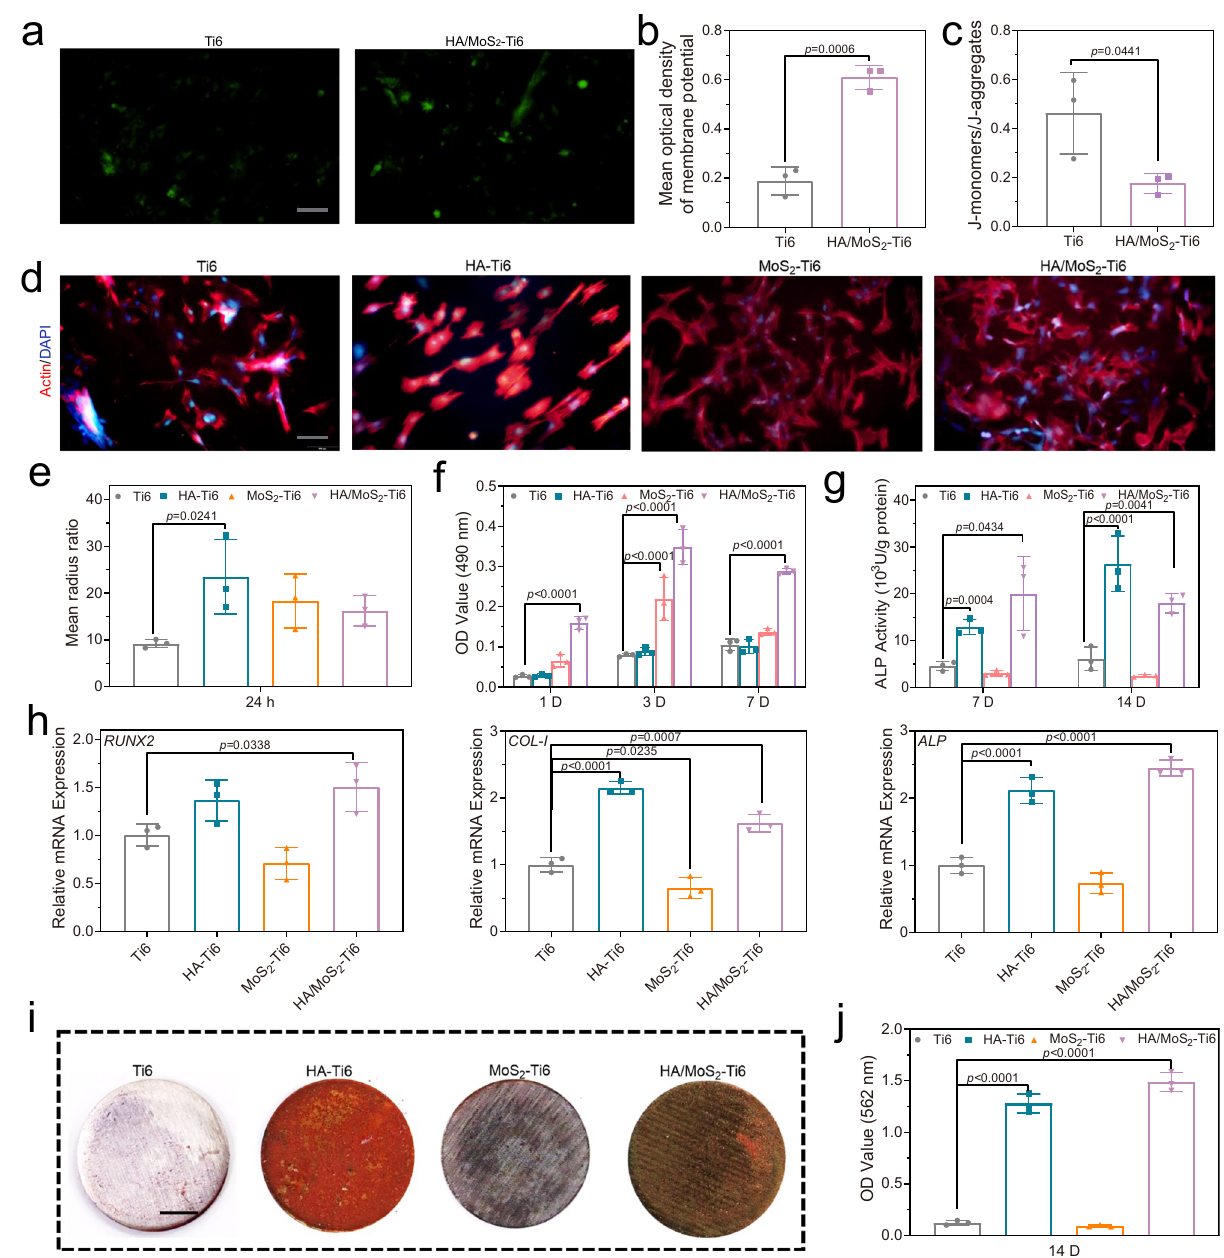
Fig. 5 Osteoblastic differentiation of MSCs by osteoconductive HA and the innate potential of HA/MoS 2 heterojunction. a Fluorescence imaging of cell membrane potential, scale bar = 100 μ m. b Quantitative analysis of fl uorescent intensity of the cell membrane potential. c Quantitative analysis of fl uorescent intensity of the mitochondria membrane potential. d Fluorescence pictures of Ti6, HA – Ti6, MoS 2 -Ti6, and HA/MoS 2 -Ti6 after culturing for 24 h. The red color represented cell actin, and the blue color indicated the cell nucleus. Scale bar = 100 μ m. e Mean radius ratio of cells in the fl uorescence pictures. f The cell viability after culturing for 1 day, 3 days, and 7 days. g The ALP activity after culturing for 3 days, 7 days, and 14 days. h Osteogenic- related gene expression of runt-related transcription factor 2 ( RUNX2 ), ALP , and type I collagen ( COL-I ) after 14 days. i Alizarin red staining of different samples after 14 days, scale bar = 0.5 cm. j Quanti fi cation of the Alizarin red staining intensity. b , c , e , h , j , f , g Data represented as mean ± standard deviations from a representative experiment. Error bar represents the standard deviation. ( n = 3 independent samples). b , c , e , h , j p -values were generated by one-way ANOVA with Dunnett ’ s multiple comparison test. f , g p values were generated by two-way ANOVA with Dunnett ’ s multiple comparison test. Source data are provided as a Source Data fi le. As illustrated in Fig. 6i, j, HA/MoS 2 – Ti6 without S. aureus group higher than the corresponding value of the Ti6 without S. aureus group (44.18%) and Ti6 + S. aureus group (12.12%). As regards and HA/MoS 2 -Ti6 + S. aureus group contained many osteoblasts Safranin-O/Fast Green staining, the osteogenesis was represented and no chondrocytes in the bone tissues. In contrast, Ti6 + S. by green color while cartilage was marked by red or orange color. aureus group contained many chondrocytes while Ti6 without S.